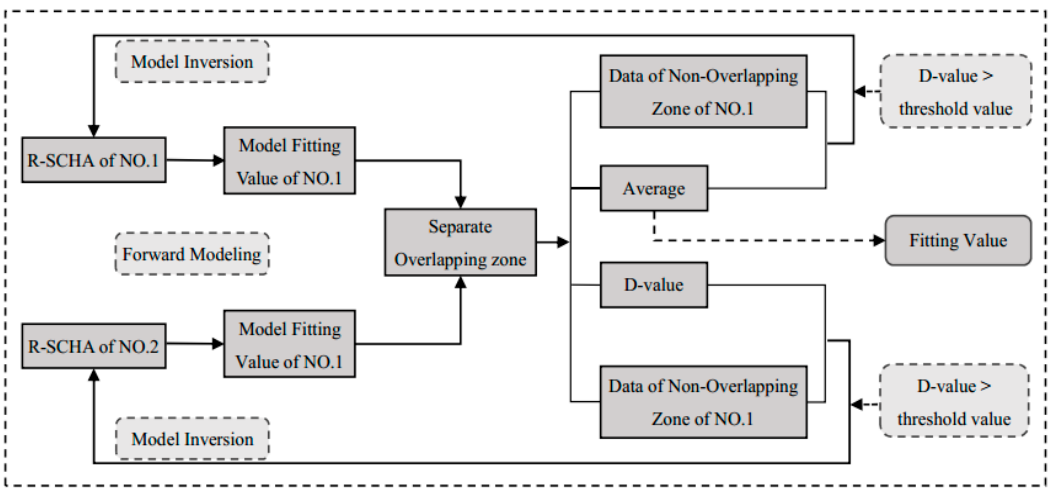
Figure 5. Flowchart showing the processing procedure for the overlapping area of the adjacent spherical caps.